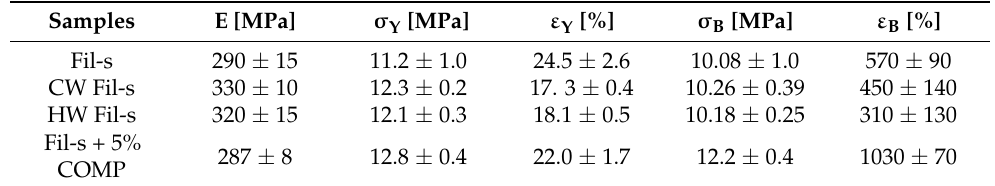
Table 4. Mechanical properties (E, Young’s modulus; σ Y , ε Y , stress and strain at yield; σ B , ε B , stress and strain at break) for all the investigated Fil-s based